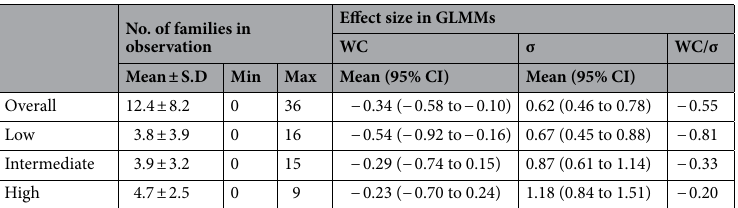
Table 1. Summary of the regional dataset and results of average generalised linear mixed models (GLMMs). Shown are the effect sizes of log-transformed water content (WC), the standard deviation of random effects (σ), and their ratio, for GLMMs in the overall dataset, and in the low-, intermediate-, and high-frequency groups. σ was significant in the overall dataset and for all frequency groups. WC was significant in the overall dataset and for the low-frequency group, but was not significant in the other two groups.